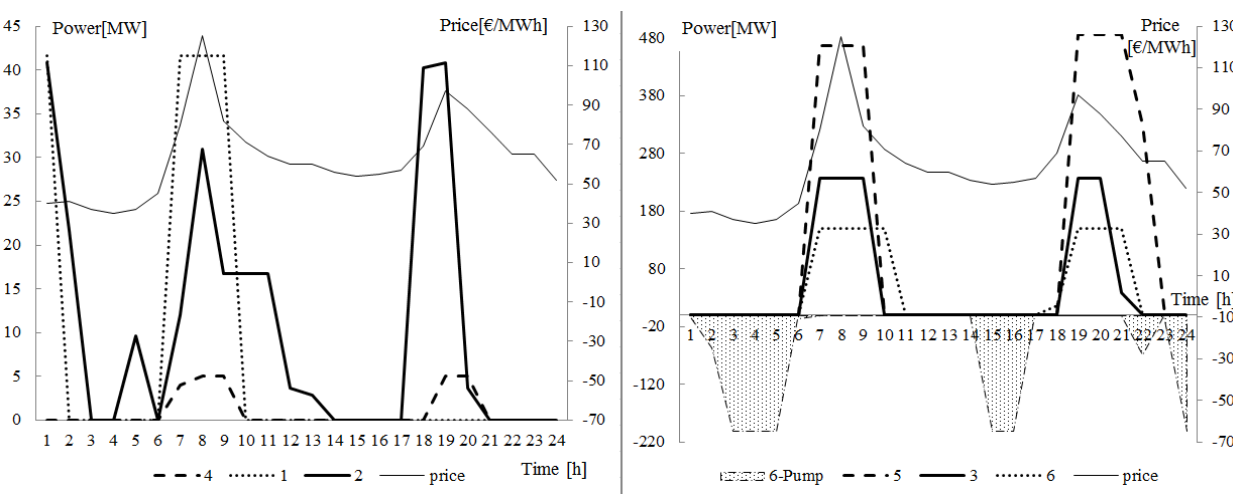
Figure 7. Optimal HC dispatch in Case